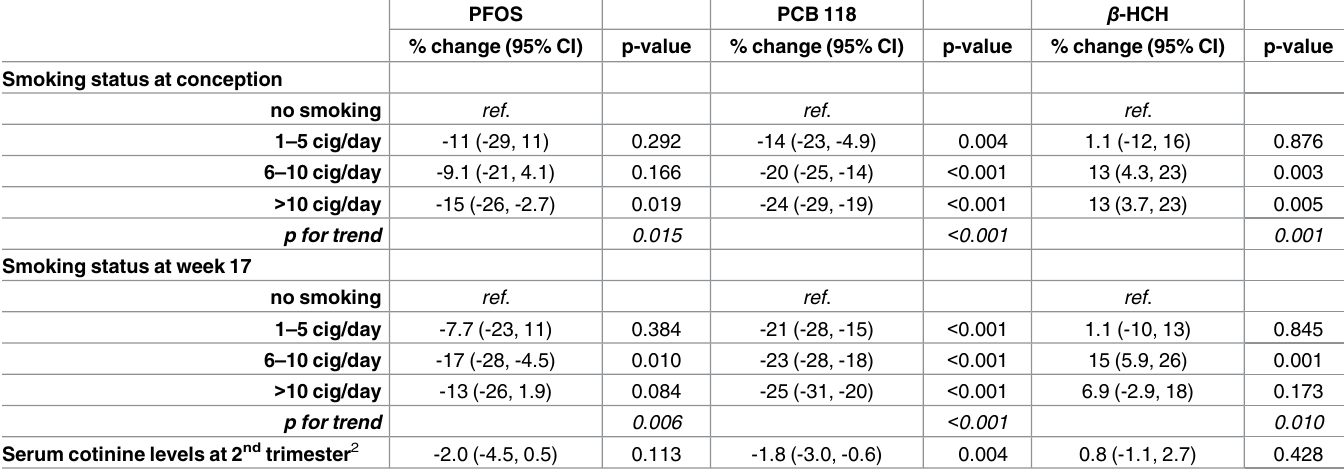
Table 4. Adjusted 1 associations from multivariable linear regression models between smoking intensity and ln-transformed maternal PFOS, PCB 118 and β -HCH levels in serum collected in 2nd trimester(n = 424).